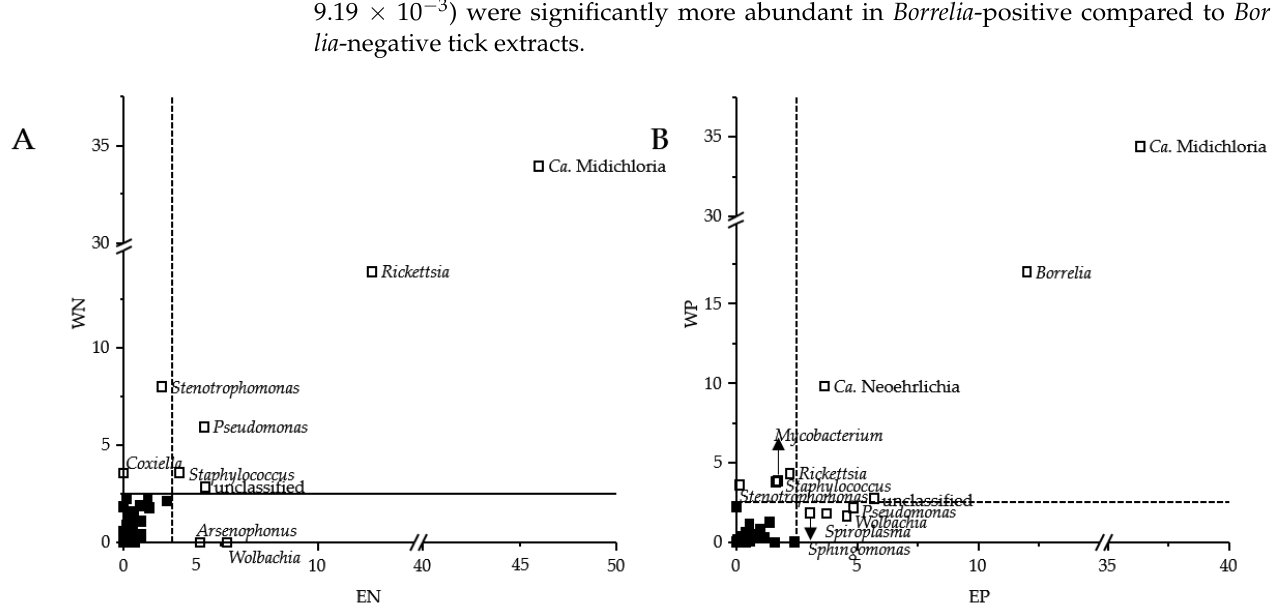
Figure 2. Differences in the sequence read abundances of bacterial genera obtained from tick-borne Borrelia -negative ( A ) (EN, n = 62; WN, n = 56) and Borrelia -positive bacterial community compositions ( B ) (EP; n = 38; WP; n = 44). Only bacterial genera were shown with a mean relative abundance of at least 2.5% in Esslingen (E) or Weiden (W).